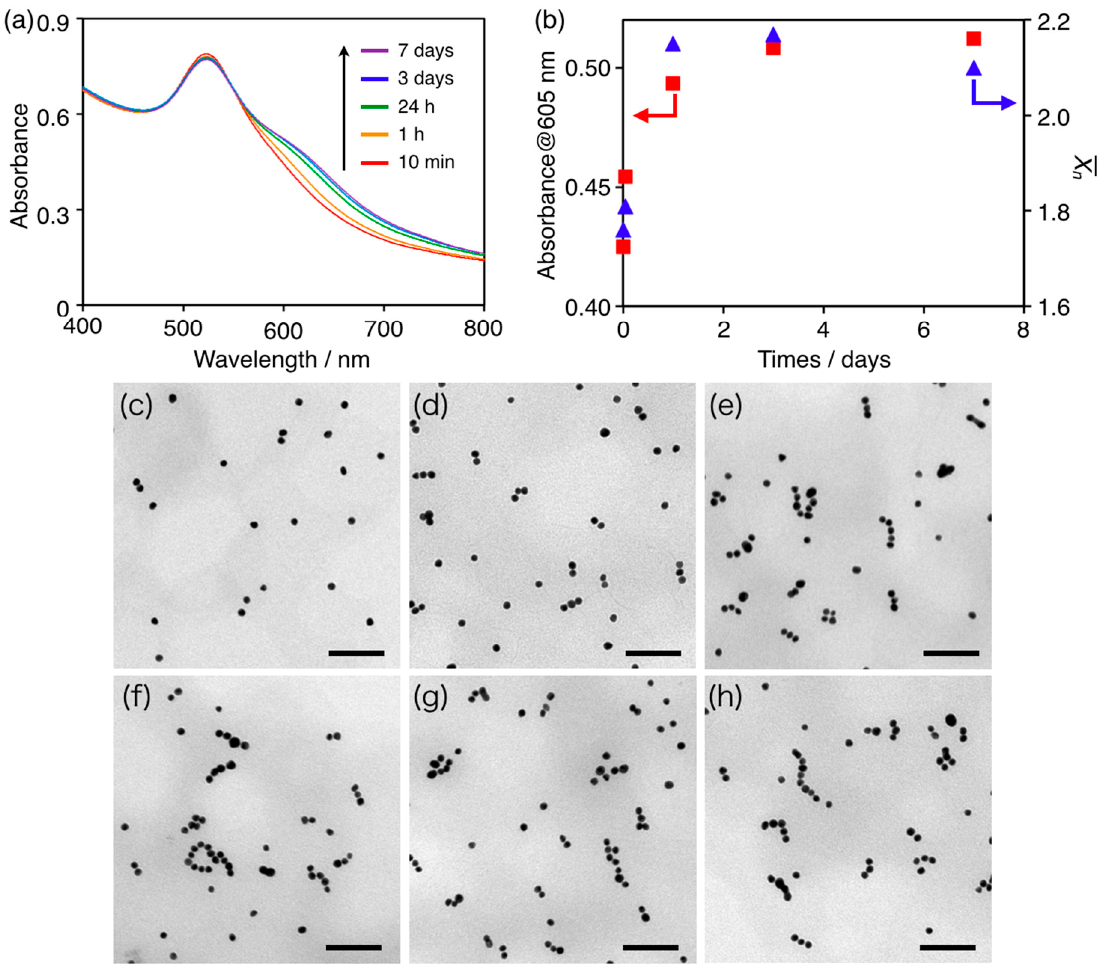
Figure 1. ( a ) Time-dependent UV–vis absorption spectra of cAuNP 14 –DPPC solutions ([cAuNP]/[liposome] = 1.67) heated at 50 °C for 10 min to 7 days; ( b ) Plots of the absorbance at 605 nm (red squares) and the average number of cAuNPs in each assembly ( X n , blue triangles) vs. heating time at 50 °C. TEM images of cAuNP 14 –DPPC; ( c ) before heating and after; ( d ) 10 min; ( e ) 1 h; ( f ) 24 h; ( g ) 3 days; and ( h ) 7 days heating at 50 °C. The scale bars are 100 nm.